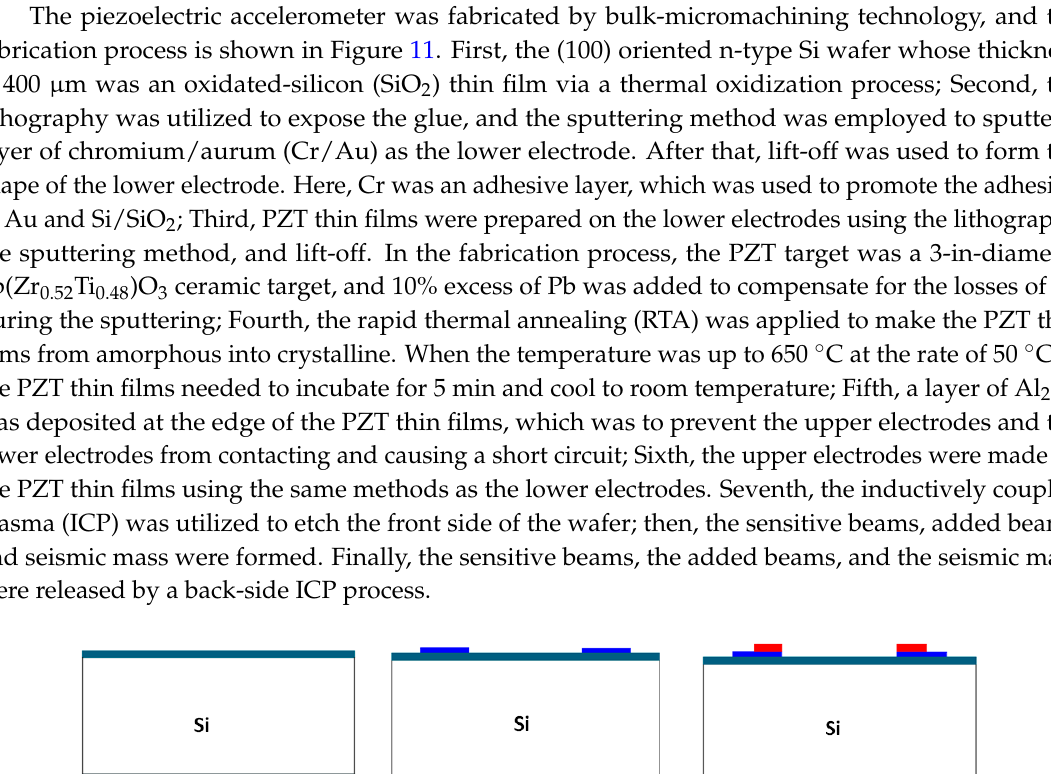
( b ) Figure 12. The distribution of maximum strain and the output voltage of the optimal structure. ( a ) The distribution of maximum strain; ( b ) The output voltage of the optimal structure.